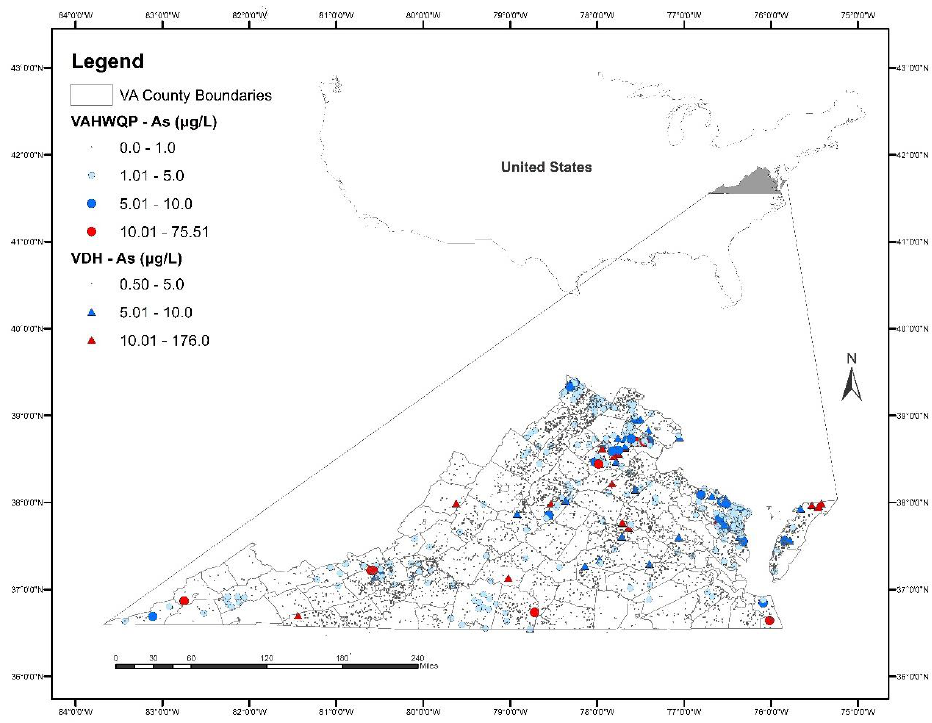
Figure 1. Distribution of arsenic (As) concentrations in well water in Virginia based on the Virginia Department of Health (VDH) and Virginia Household Water Quality Program (VAHWQP) datasets. Outline of the U.S. showing Virginia in the inset map. Table 3. Distribution of As concentrations from VDH and VAHWQP datasets for geologic units in Virginia.